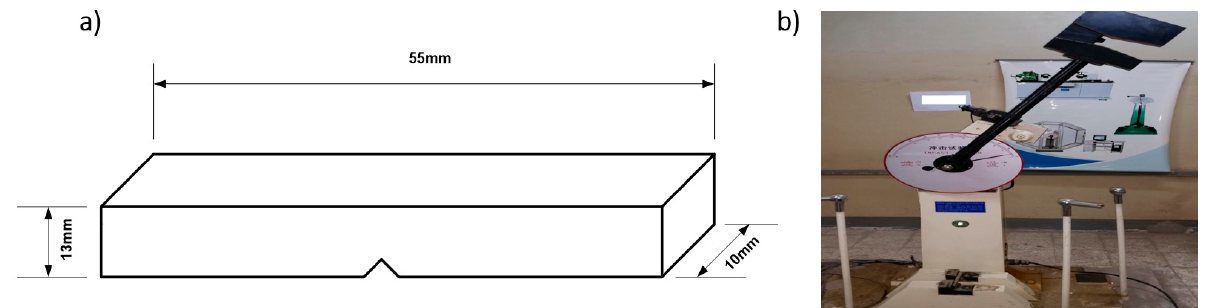
Figure 6. Charpy Impact test: ( a ) specimen geometry, ( b ) test